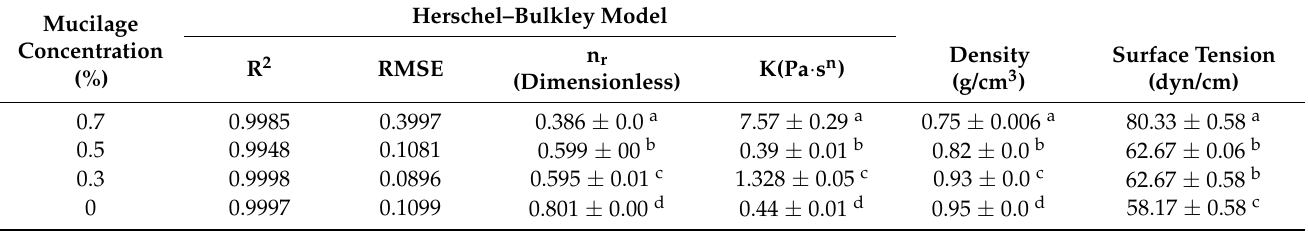
Table 2. Rheological and physicochemical parameters of the solutions at different mucilage–alginate